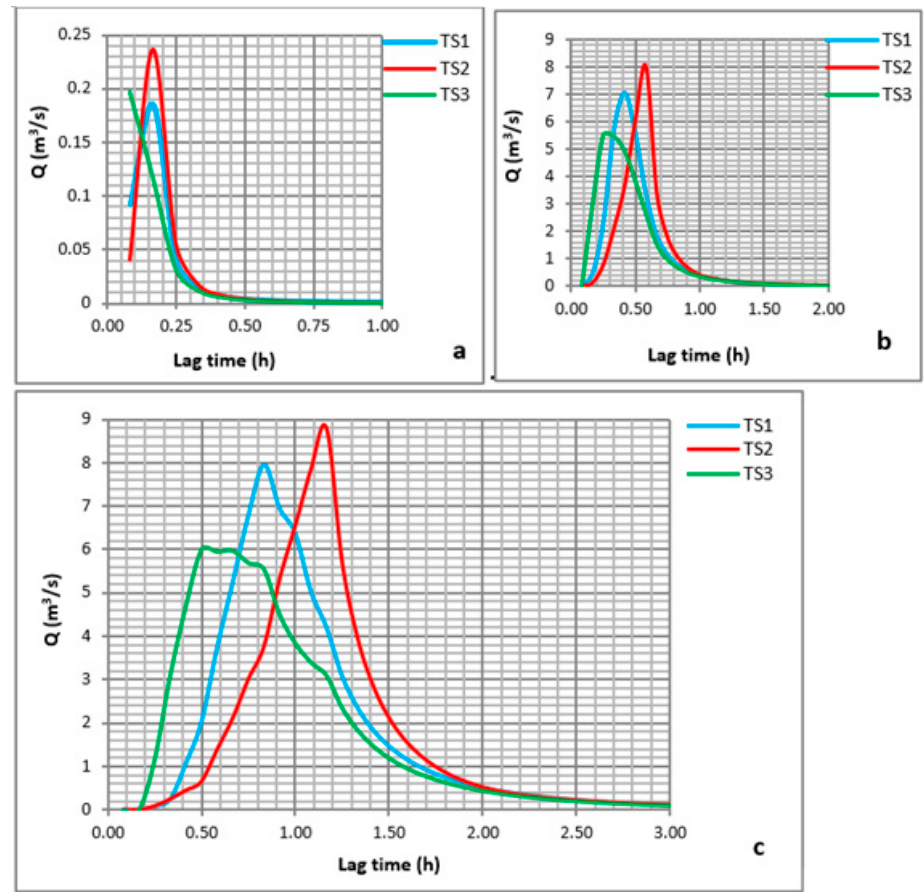
Figure 11. Effect of rainfall patterns on peak runoff and time to peak for rainfall durations of: ( a ) 10 min; ( b ) 30 min and ( c ) 1 h.